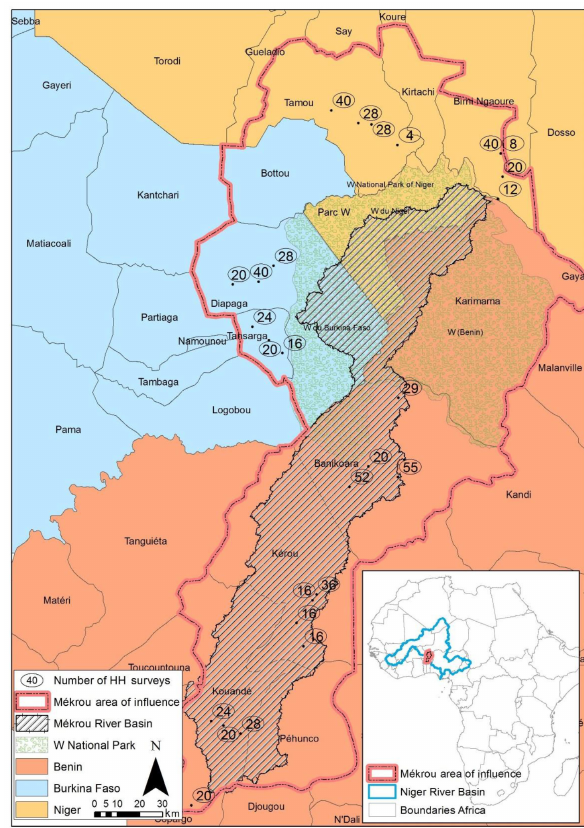
Figure 1. The Mékrou River basin and the household survey area (including number of questionnaires per